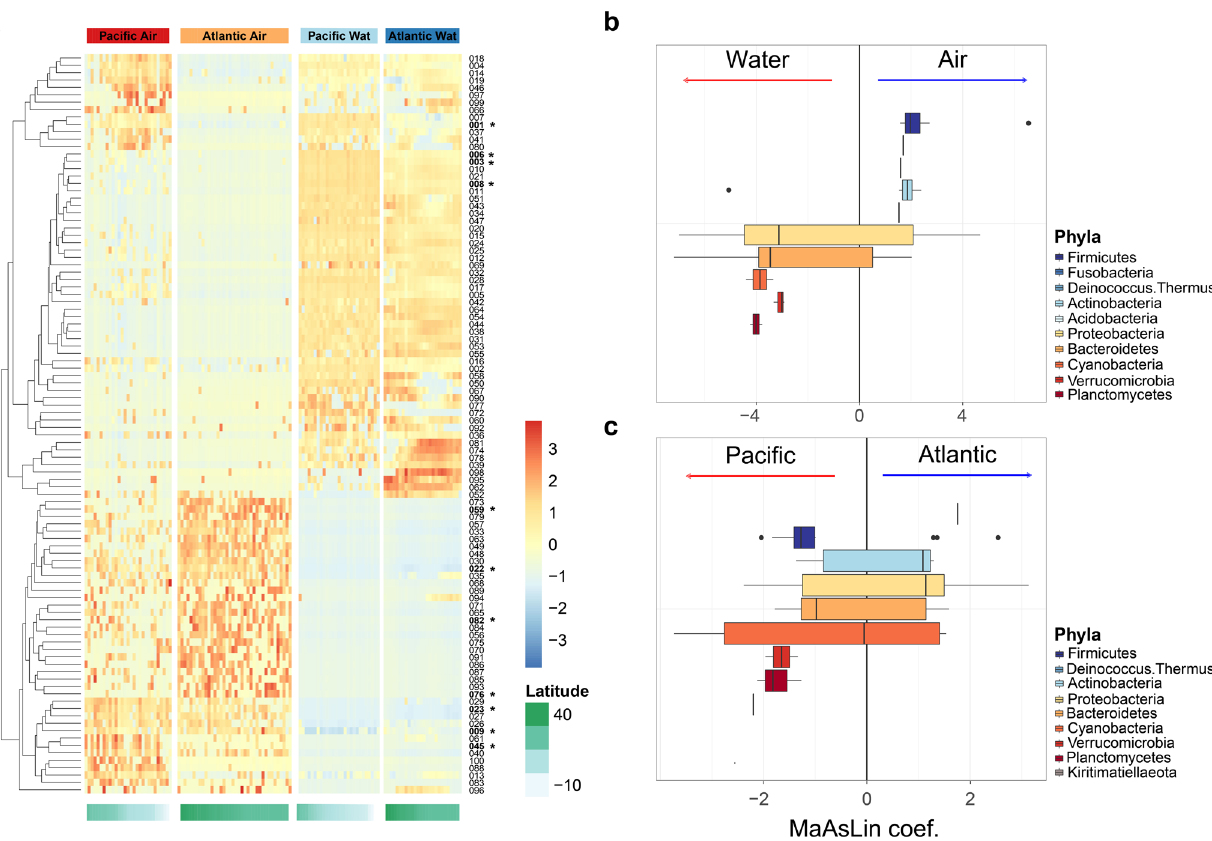
Fig. 3 Spatial distribution of speci fi c airborne microorganisms across the Atlantic and Paci fi c transects. The 100 Bacterial taxa, with the highest score and signi fi cance of <0.05 for association with a speci fi c environment (Atlantic or Paci fi c; air or water; tested using MaAsLin2 for multivariable association discovery in population-scale studies) are clustered based on phylogenetic similarity and scaled in a heatmap based on centered log-ratio (CLR)-converted abundance ( a ). Highlighted taxa in the text are indicated with an asterisk and speci fi ed in Supplementary Data 5. The MaAsLin2 score per phylum are presented with association to water and air ( b ), and Atlantic and Paci fi c ( c ). Error bars represent the standard error of the MaAsLin2 coef fi